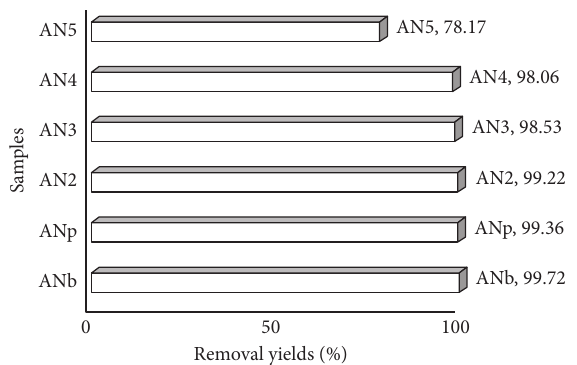
Figure 15: Influence of initial concentration dye and adsorbent dose onto different samples. AN2: activated clay with 0.5N HCl; AN3: activated clay with 3N HCl; AN4: activated clay with 2N H 2 SO 4 ; AN5: thermally activated clay (500 ° C).